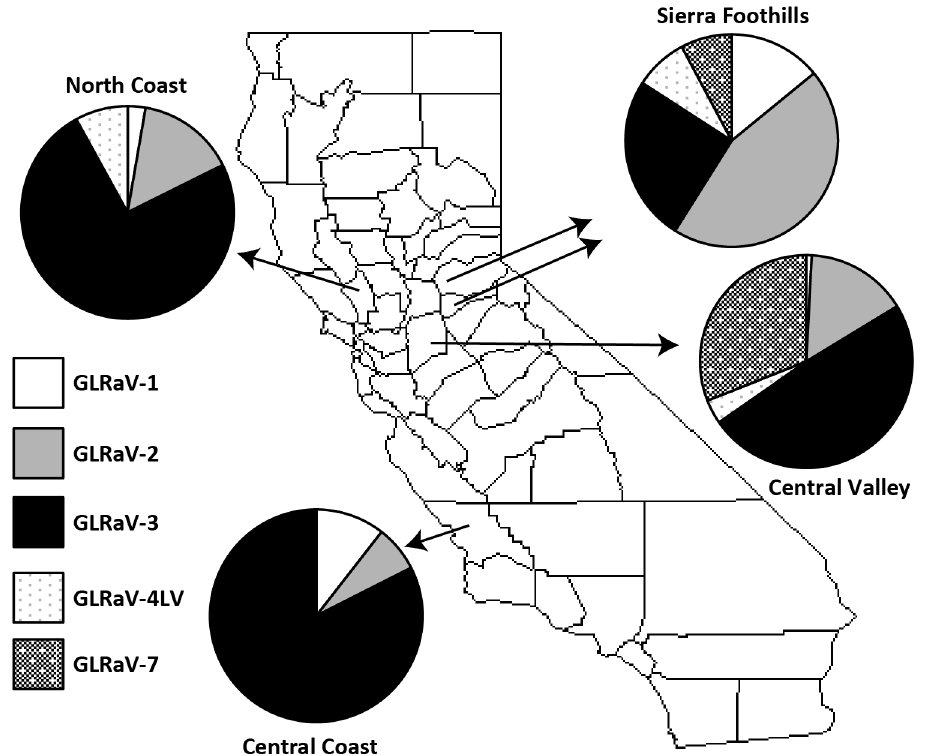
Fig 2. Relative prevalence of grapevine leafroll-associated virus species by region. Data for the North Coast region were obtained from Sharma et al. 2011; GLRaV-7 was not tested in that survey. The map was generated by authors with R version